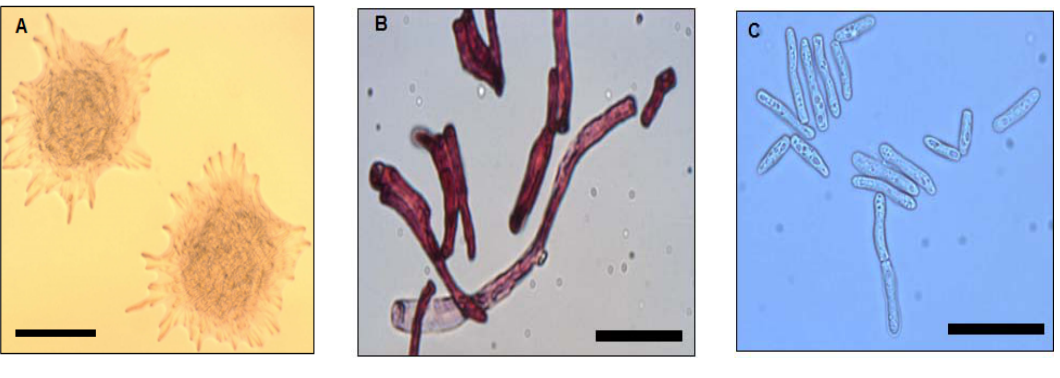
Figure 1. Colonial and cell morphology of strain WW1C. ( A ) Photograph of colonies grown on LBm; ( B ) Light micrograph of Gram-stained cells of strain WW1C grown on LBm plates; ( C ) Light micrograph of a droplet of overnight LBm broth culture of strain WW1C stained with crystal violet. The bars represent 500 µm (A), 50 µm (B), and 100 µm